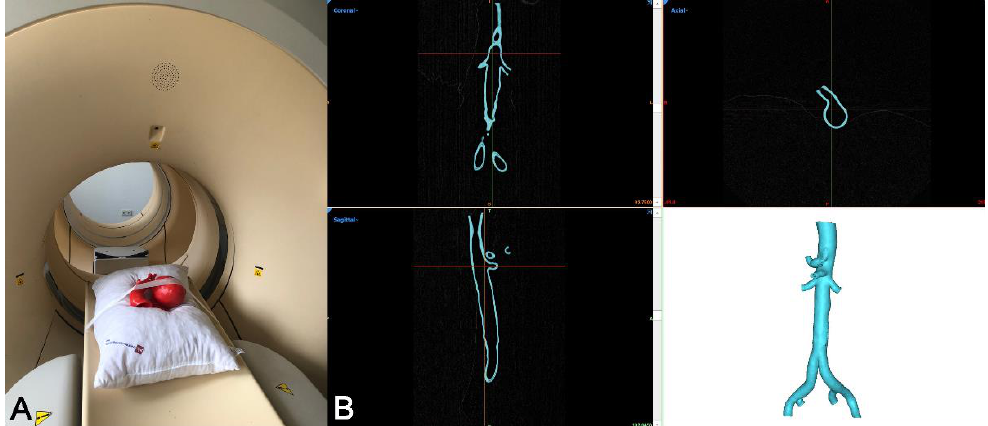
Figure 3. CT scanning of the 3D-printed model. ( A ): A high-resolution CT scan (slice thickness 0.4 mm) was obtained from all 35 3D-printed models. ( B ): The 3D model was segmented using MIS, and an STL file (3D model STL) was generated.